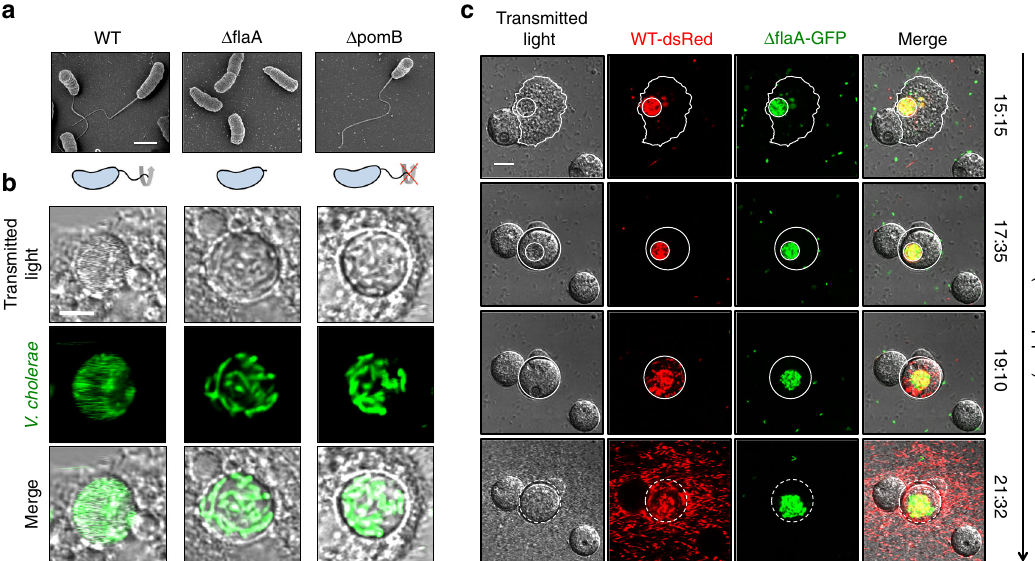
Fig. 6 Ef fi cient escape from the ruptured CV and the lysed cysts requires fl agellum-based motility. a Scanning electron micrographs of WT V. cholerae and its fl aA - and pomB -de fi cient derivatives, which lack the major fl agellin and cannot rotate their fl agellum, respectively (as schematized below the images). Scale bar: 1 µ m. b Close-up view of confocal scanning images of CVs (transmitted light) that were colonized by each one of the three GFP-tagged strains shown in a . The scanning speed was lowered for these experiments to visualize the fast movement of WT V. cholerae inside the CV. See also Supplementary Movies 2 to 4 for dynamics of intra-vacuolar WT, Δ fl aA, and Δ pomB bacteria. Scale bar: 5 µ m. c Escaping from the lysed amoebal host and spreading requires fl agellum-based motility. A. castellanii was infected with a 1:1 mixture of WT (dsRed-tagged) and non-motile fl aA -minus (GFP-tagged) bacteria. Time-lapse microscopic imaging of a co-infected amoeba was started at 15 h p.p.c and followed for more than six hours (time is indicated on the right). Still images derived from the recorded movie (Supplementary Movie 5) are depicted and show (from top to bottom) the colonized trophozoite before and after encystation, after rupture of the CV, and after cyst lysis. Scale bar: 10 µ